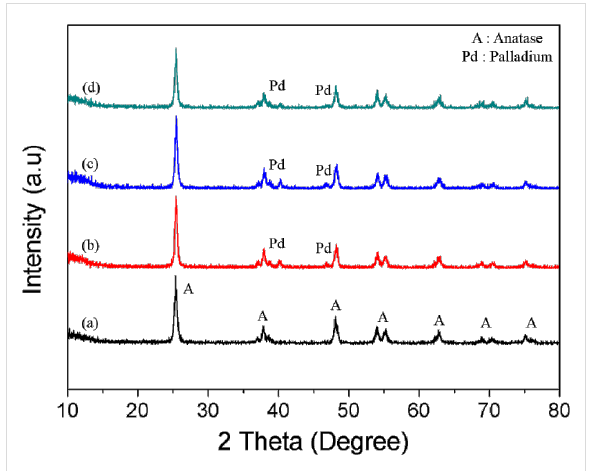
Figure 3: X-ray diffraction patterns of a) TiO 2 , b) 0.5 wt % Pd/TiO 2 , c) 1.0 wt % Pd/TiO 2 and d) 3.0 wt % Pd/TiO 2 .